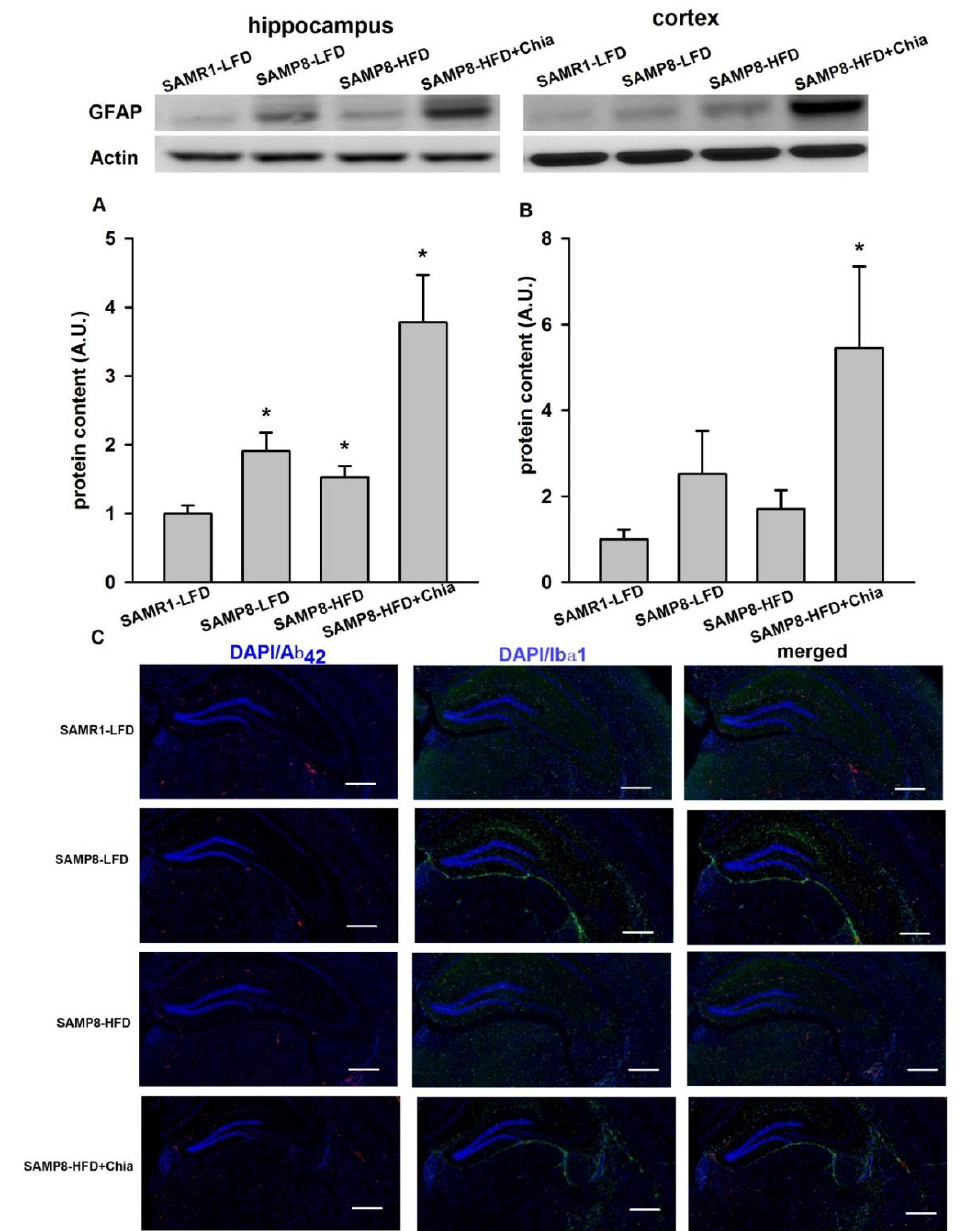
Figure 6. GFAP protein expression in the hippocampus and cortex and immune-staining for A β 42 + Ib α -1. Protein expression of GFAP in the hippocampus ( A ) and cortex ( B ) from all groups measured via Western blotting. Immune-staining for A β 42 + Ib α -1 surrounding hippocampus area measured via immunofluorescence ( C ). Representative blots are shown at the top of quantified data in ( A , B ). A.U. means arbitrary units. Data are presented as means + SEM for 8 mice per group in ( A , B ). Scale bar 20 µ m, magnification × 200 in ( C ). * p < 0.05 versus SAMR1-LFD